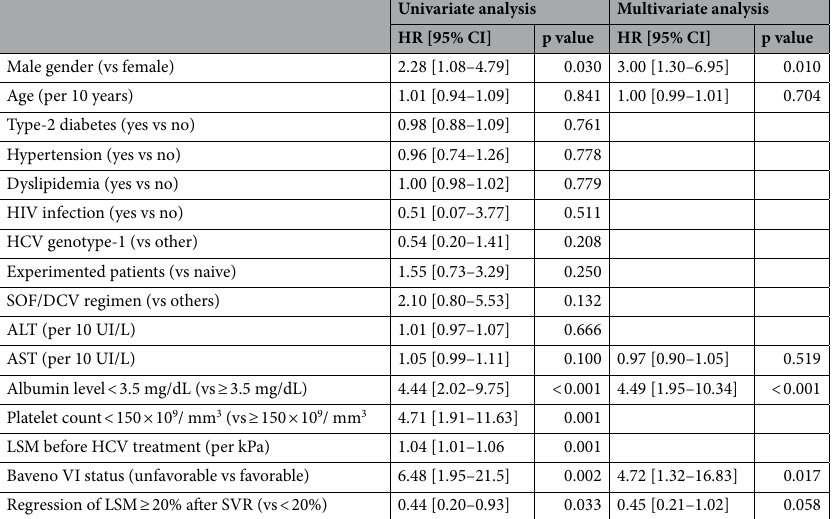
Table 3. Factors associated with incidence of liver related complications or death during follow-up after sustained virological response. A time-dependent Cox model was used for the analysis. Variables found to be associated (p value ≤ 0.10) with LRC or death in the univariate analysis were entered into the multivariate Cox models adjusted for age and gender. The variable Baveno VI status (favorable vs. unfavorable) replaced the variables LSM and platelet count at baseline in the models due to collinearity. Baveno VI status was defined as unfavorable if LSM ≥ 20 kPa or platelet count < 150 × 10 9 / mm 3 . Liver-related complications were ascites, hepatic encephalopathy, variceal bleeding or hepatocellular carcinoma. ALT alanine aminotransferase, AST aspartate aminotransferase, CI confidence interval, DCV daclatasvir, HR hazard ratio, LSM liver stiffness measurement, SOF sofosbuvir, SVR sustained virological